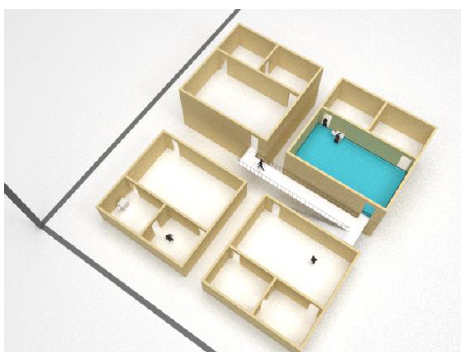
Figure 3. Location defines a general placement relative to well- defined physical space. For example in the figure the person can be said to be located in the room. The uncertainty in the position of the person is defined by the extent of the room. It should be noted that the speaker provides the context of the space.